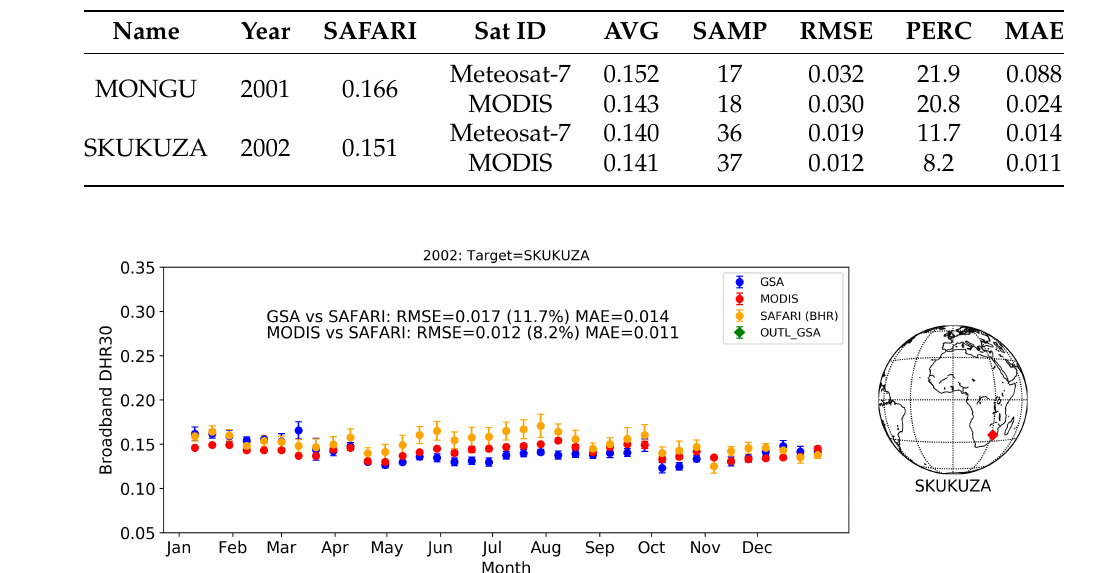
Table 8. Comparison against SAFARI data (BHR) RMSE, PERC and MAE for GSA and MODIS DHR30 for the selected sites and periods. Values are computed using 5 × 5 Meteosat pixels around the site location. AVG is the GSA or MODIS average. Statistics calculated over the SAMP number of decads (10 day periods).